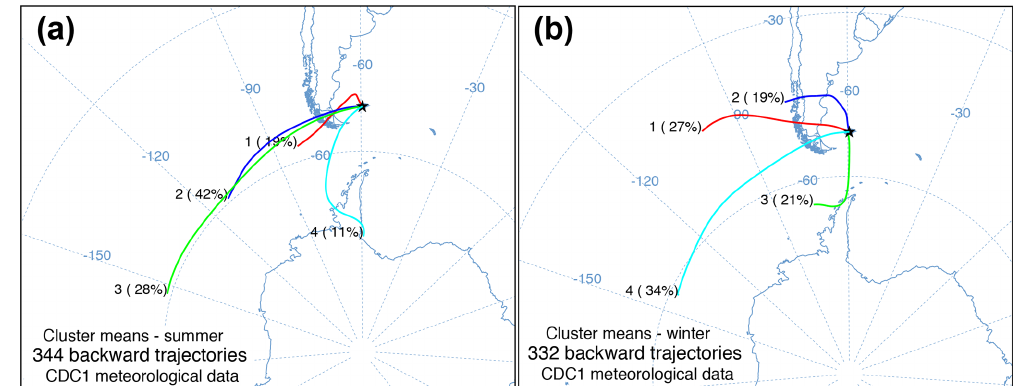
Figure 3. HYSPLIT seasonal cluster means of daily 5d back trajectories from (a) summer and (b) winter at 51.79 ◦ S, − 59 . 52 ◦ W with the percentage of daily trajectories in each cluster and number of daily